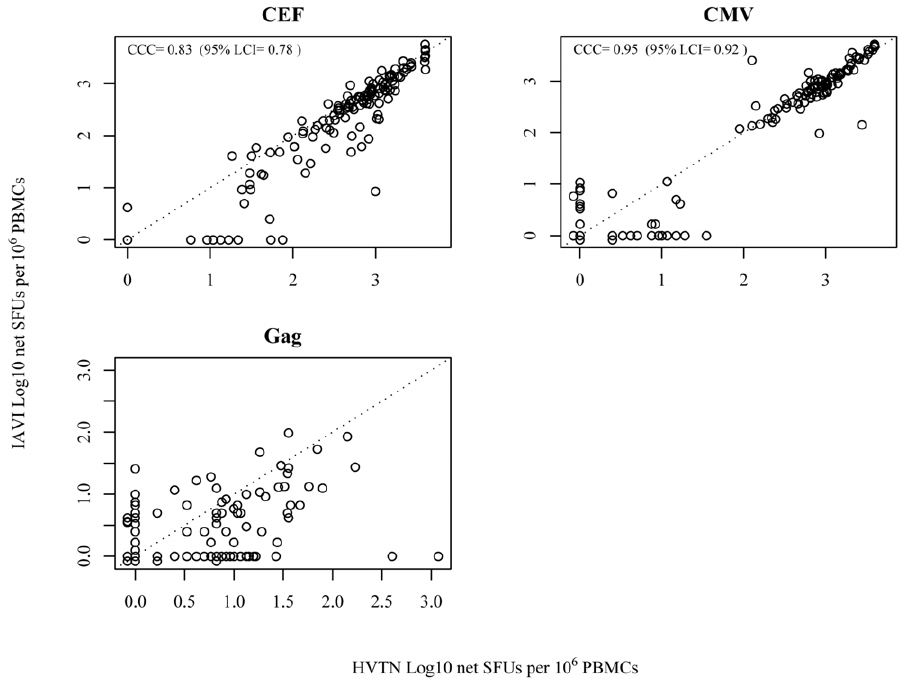
Figure 3. Scatter plot of all net CMV IFN-g ELISpot responses between the IAVI & HVTN. The dotted line is an identity line indicating perfect concordance. The CCC’s were calculated based on methods referred in section 4.5. SFU=spot forming units.